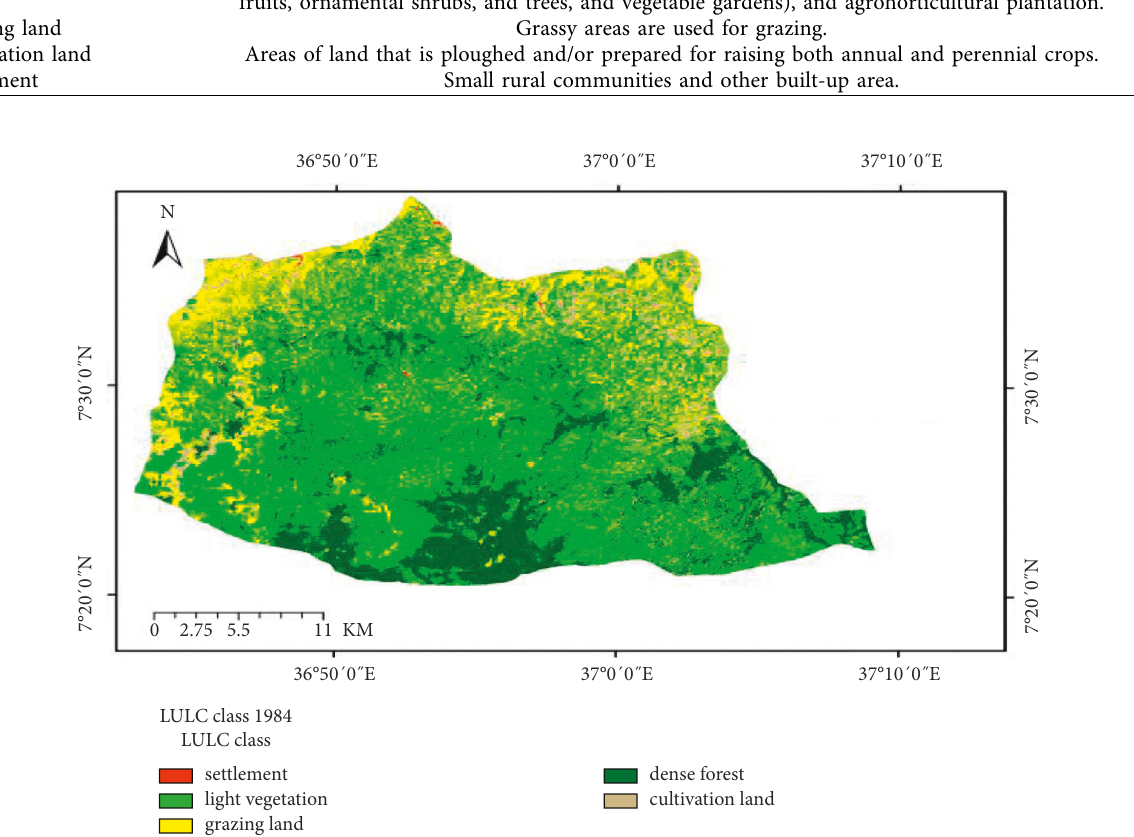
Figure 2: Land use land cover map of